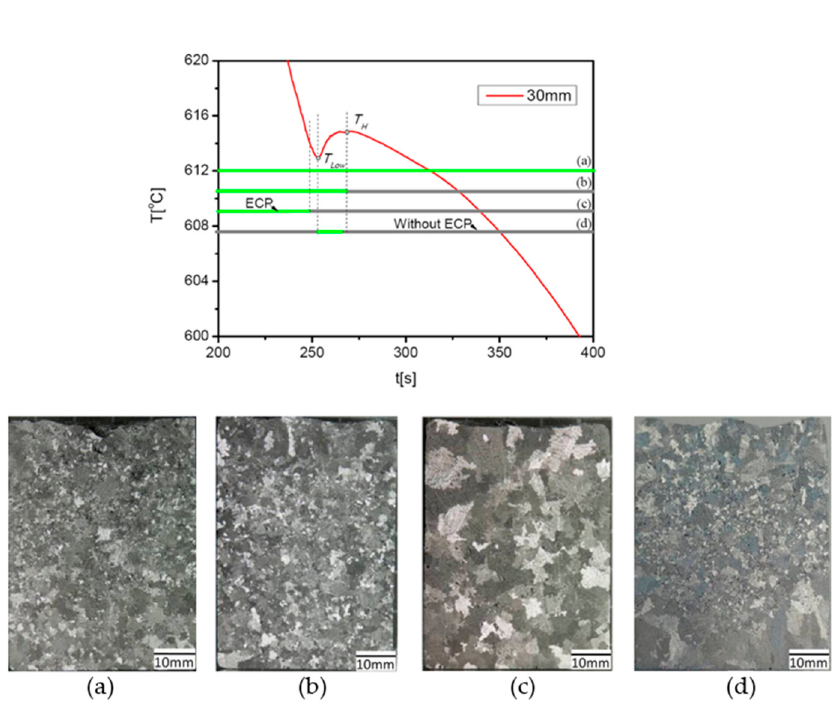
Figure 5. Influence of ECP application time on the longitudinal section macrostructure of the solidified Al ‐ 7 wt. %Si alloy: ( a – d ) correspond to the various application time shown in the schematic view (green line: turn on ECP; grey line: turn off ECP).